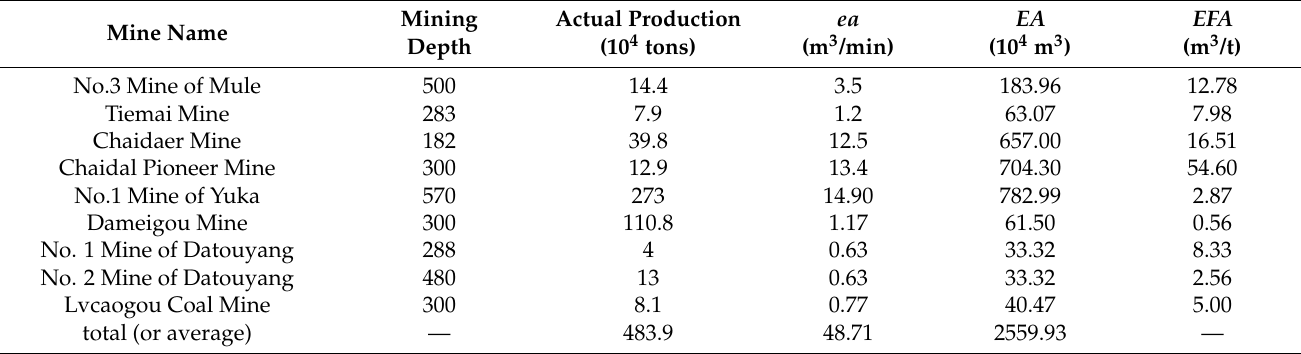
Table 2. Survey and calculation results of coal mining and CH 4 emission in Qinghai